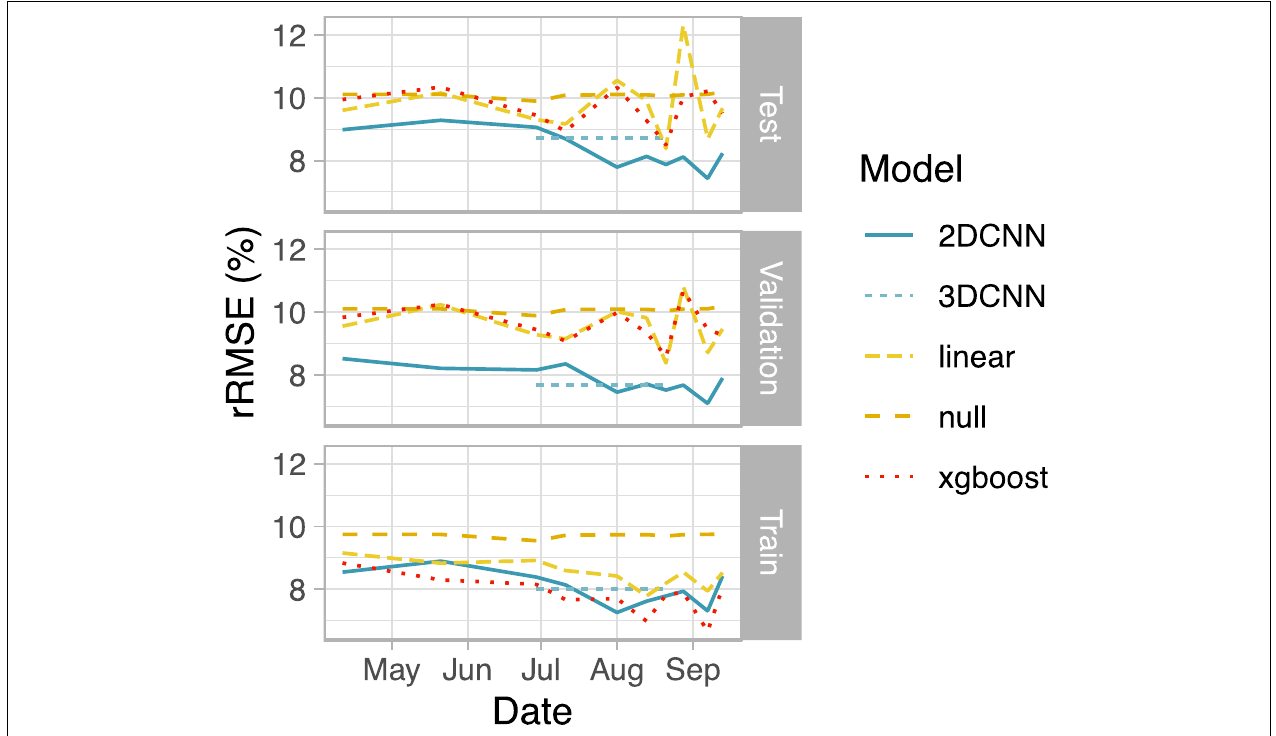
FIGURE 3 | Summary of model performance. Root mean squared error (RMSE) relative to the mean yield for the field is shown as the average across all four data folds. Note that results for the 3DCNN are for a single model based on input from five time points together, with relative RMSE (rRMSE) shown as a constant value across the five included time